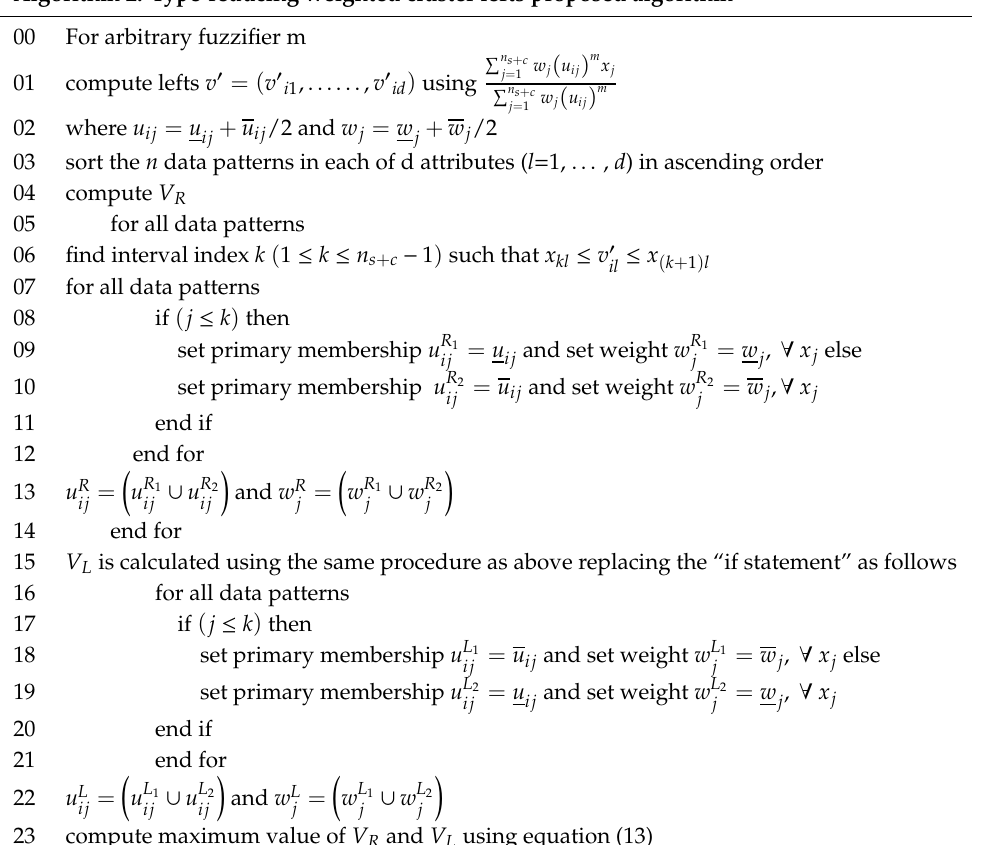
Algorithm 2: Type-reducing weighted cluster lefts proposed